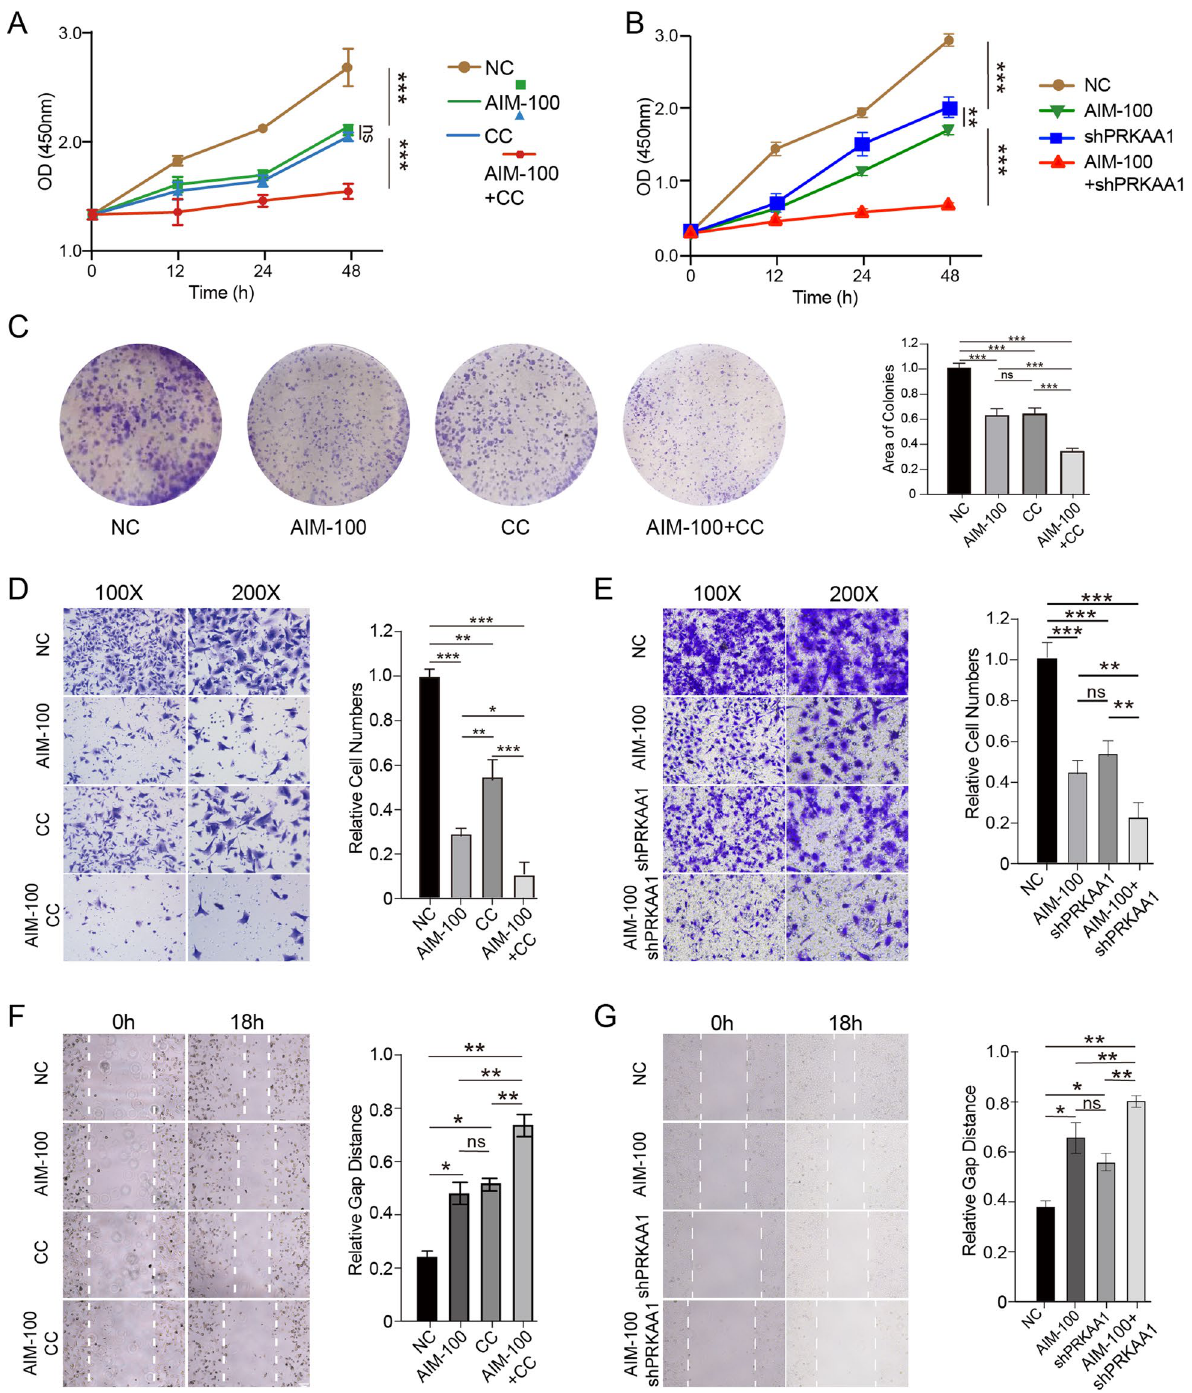
Fig. 7 AMPK inhibitor compound C (CC, 20 μM) and shPRKAA1 reinforced the cytotoxic effects of AIM-100 (20 μM) on A549 cells. A A CCK8 assay for A549 cells treated with AIM-100, CC, or both agents for 48 h. B Impacts of AIM-100, shPRKAA1, or combined treatments on the proliferation of A549 cells). C The colony formation assay was adopted to estimate the influences of indicated treatments on A549 cell proliferation. Colony formation was estimated after cells were treated for ten days. D – G Wound-healing ( D , E ) and transwell migration assays ( F , G ) were used to check the effects of indicated treatments on A549 cells’ migration abilities, which were evaluated after cells were treated with indicated agents for 18 h. *P < 0.05, **P < 0.01, ***P <